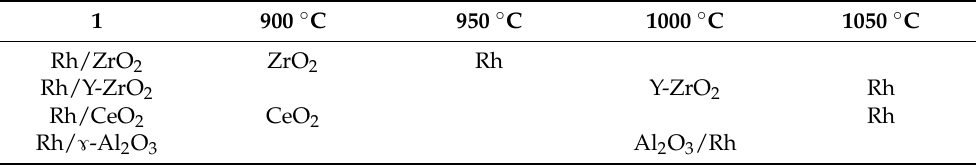
Figure 5. TEM images and EDS mapping of Rh in Rh/Al 2 O 3 under vacuum conditions at ( a ) 300 °C, ( b ) 900 °C, ( c ) 950 °C, ( d ) 1000 °C, and ( e ) 1050 °C. Table 1. Summary of the starting temperatures for the support materials and Rh particles .